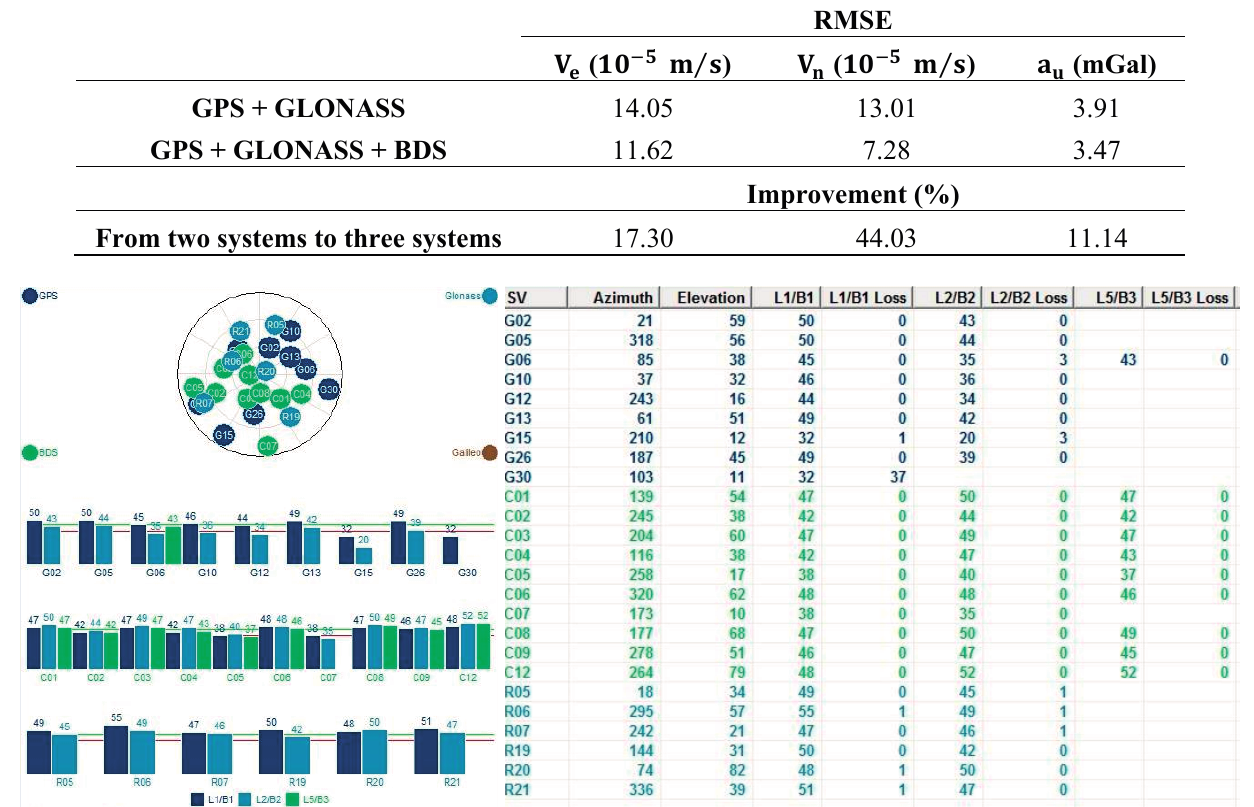
Figure 8. MB5000 GNSS antenna and receiver. Table 2. Statistics of kinematic velocity and acceleration computed using different combinations of GNSS data.